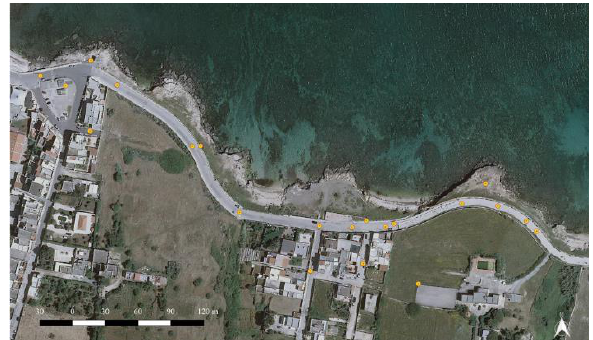
Figure 1. WMS Service of SIT Puglia © Orthophoto 2016. Representation of the 30 GCP/CP distribution in the scenario by means of orange dots.